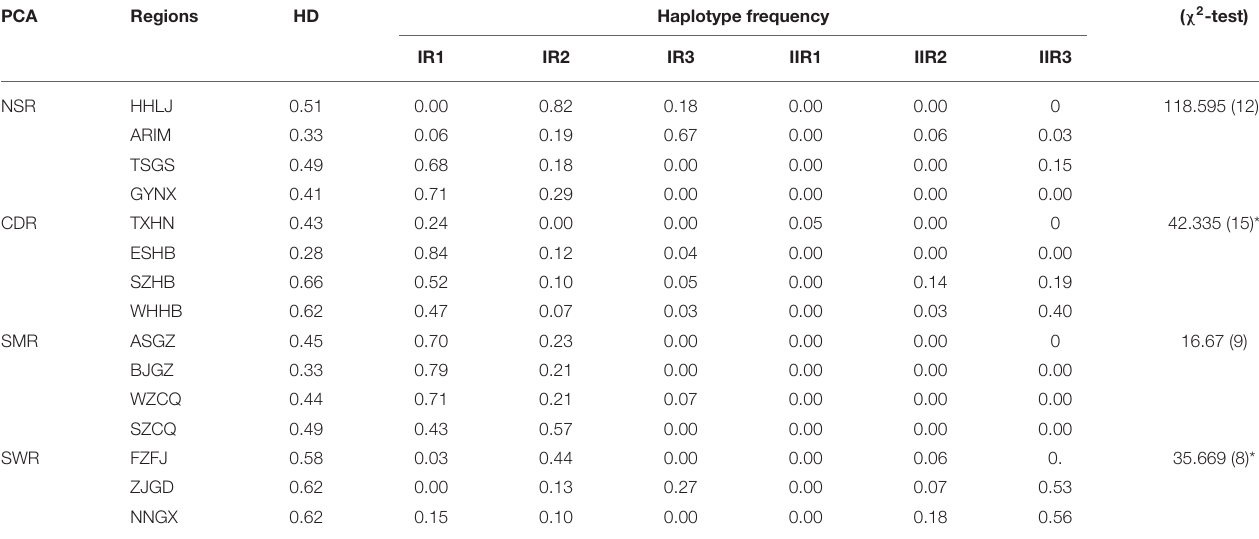
TABLE 2 | Mitochondrial diversity and homogeneity test for haplotype frequency in the 15 Phytophthora infestans populations sampled from China. PCA Regions HD Haplotype frequency ( χ 2